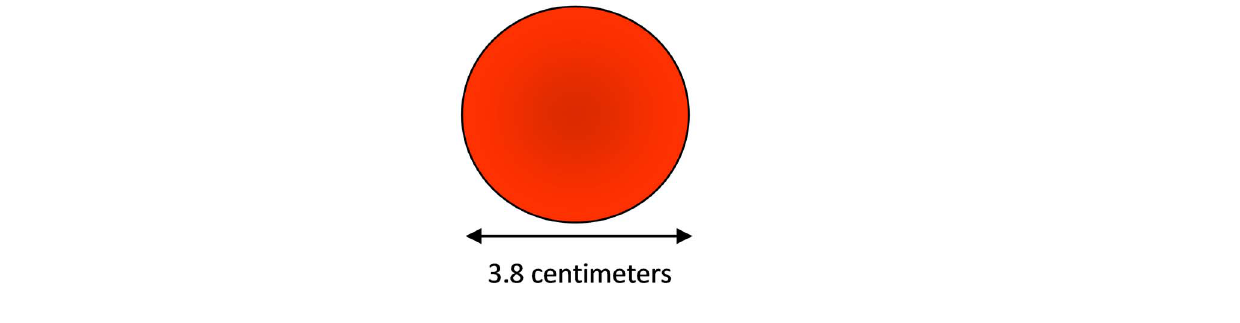
Figure 1. Description of Draining Sore Vignette.